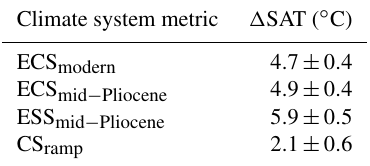
Table 5. Transient climate sensitivity (CS), equilibrium climate sensitivity (ECS), and Earth system sensitivity (ESS) based on COSMOS PlioMIP2 simulations of 2m temperature following the definition by Lunt et al. (2010). We define here the terms CS, ECS, and ESS as the surface air temperature change ( (cid:49) SAT) that arises if the volume mixing ratio of carbon dioxide (CO 2 ) is doubled from 280 parts per million by volume (ppmv) to 560ppmv. We show ECS for modern geography (ECS modern , based on E560 and E280), ECS for mid-Pliocene geography (ECS mid − Pliocene , based on Eoi560 and Eoi280), ESS of the mid-Pliocene (ESS mid − Pliocene , based on Eoi560 and E280), and transient CS derived from the CMIP6 1% “ramp-up” simulation (CS ramp , based on 1pctCO2 and E280C). All values are based on annual averages and standard deviations over the analysis period of 100 model years, except for CS ramp , which is based on an average over 29 model years centred on the year that is closest to a CO 2 forcing of